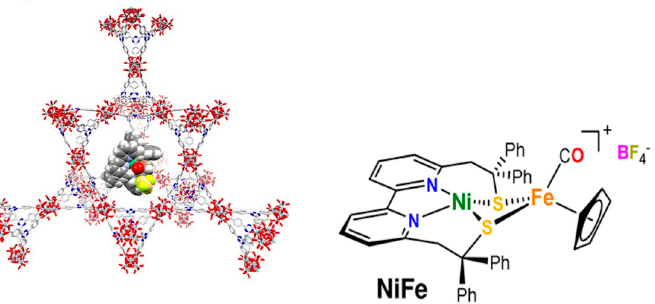
Figure 13. Advanced hydrogenase mimic NiFe@PCN-777. Adapted with permission from (Balestri et al., 2017) [110]. Copyright 2017 American Chemical Society. MOF-818, containing trinuclear copper centers mimics the active sites of catechol oxidase, possessing efficient catechol oxidase activity with good specificity [111]. Other examples of redox-active enzymes may be found in Table